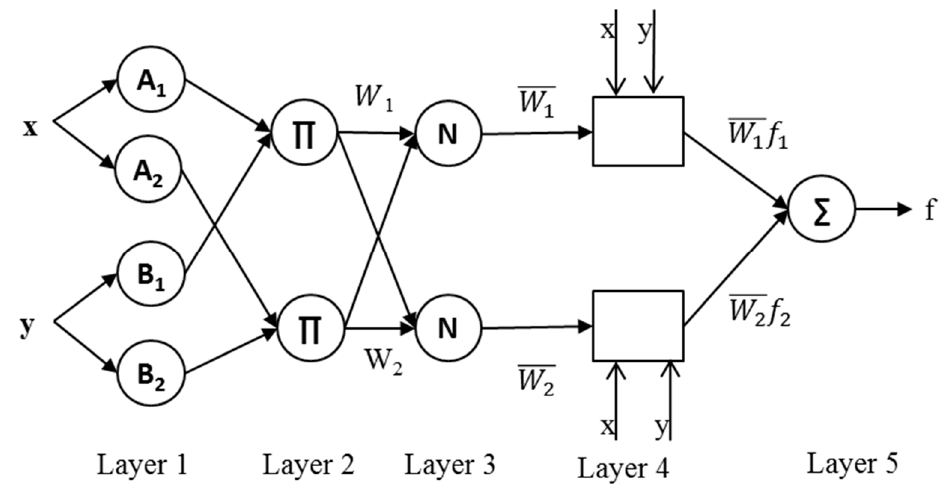
Figure 3. A typical structure of ANFIS.